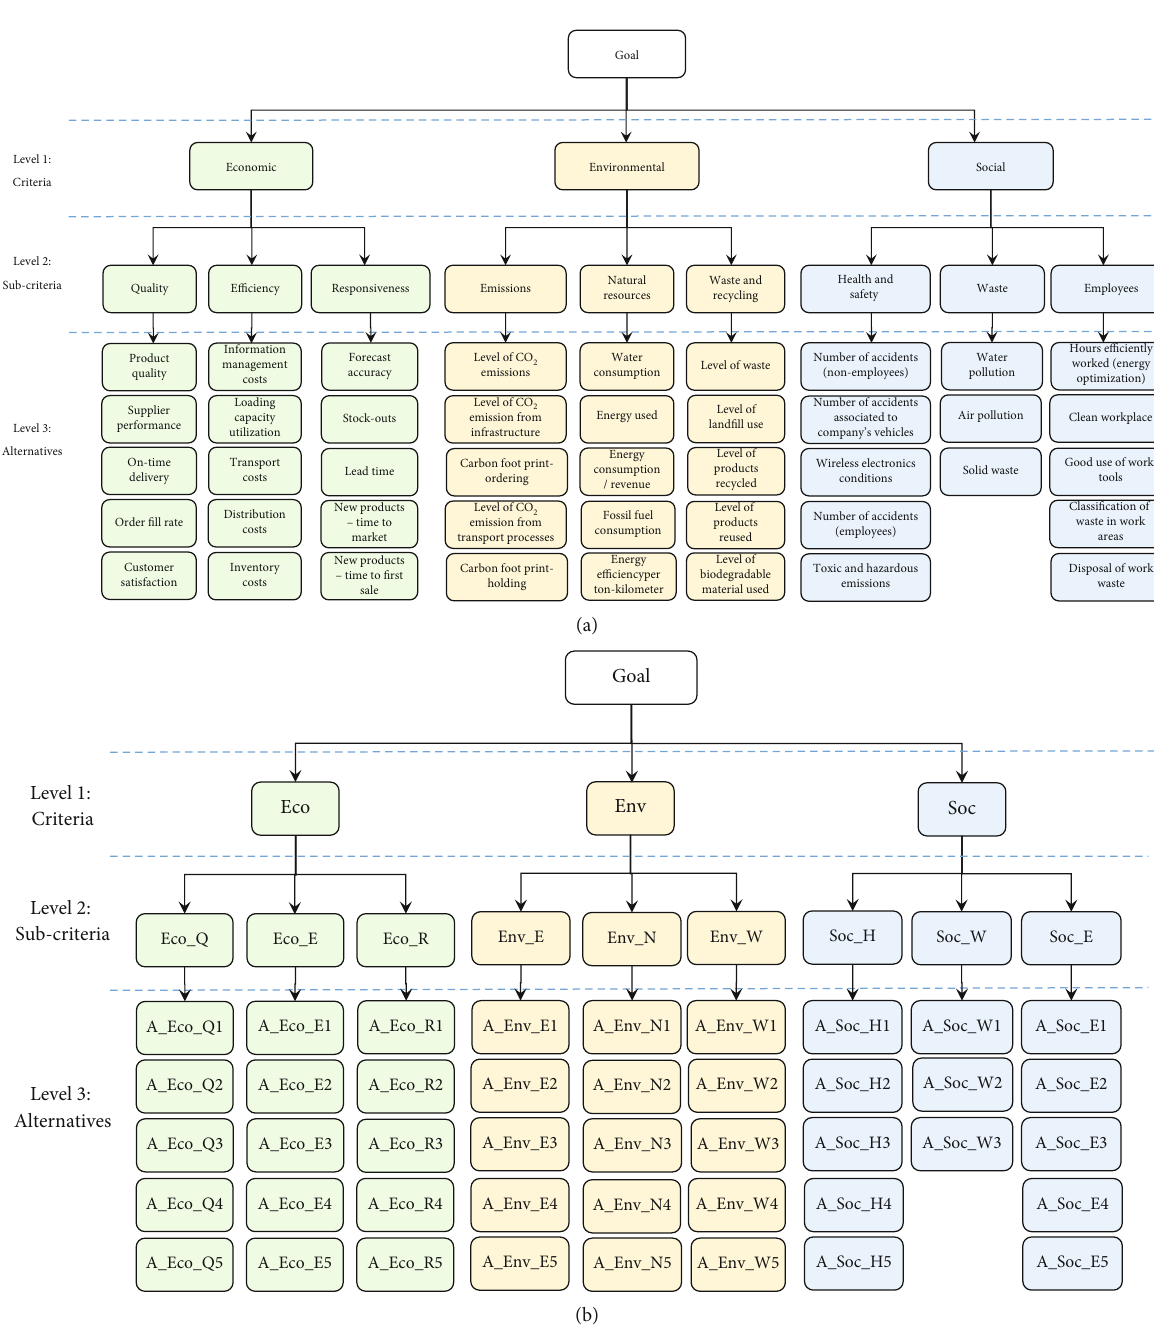
Figure 1: Hierarchical structure of the information reported in Table 3: (a) descriptive structure and (b) abbreviated structure (own